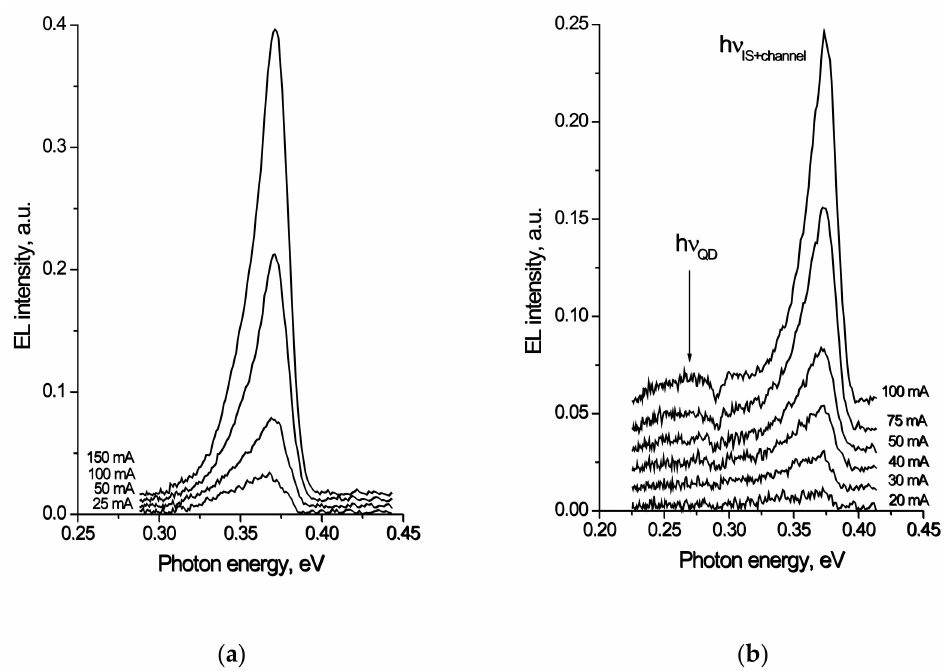
Figure 5. EL spectra of p -InAs/InSb/ n -InAs heterostructures with InSb QDs (( a ) sample B and ( b ) sample C), measured at reverse bias at T = 77 K.